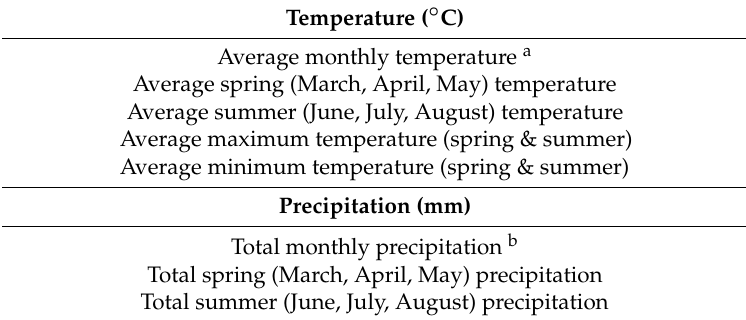
Table 2. Climatic variables legend for correlation analysis and regression equations